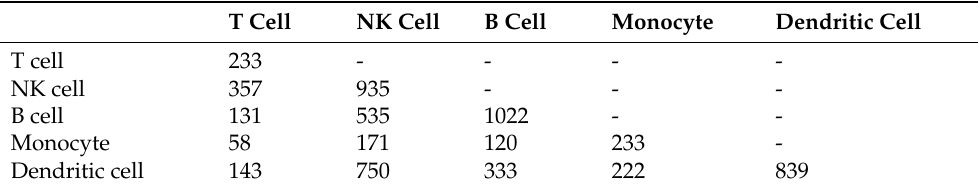
Table 1. Unique pairwise overlap between IMMUNETS cell types. Counts are shown for genes that are represented in only one (diagonal) or exactly two (off-diagonal) IMMUNETS networks. For example, the top left value (for T cell, T cell) identifies 233 genes present only in the T-net network, the value of 357, immediately below, corresponds to genes found in T-net and NK-net but not present in any other IMMUNETS network. T Cell NK Cell B Cell Monocyte Dendritic